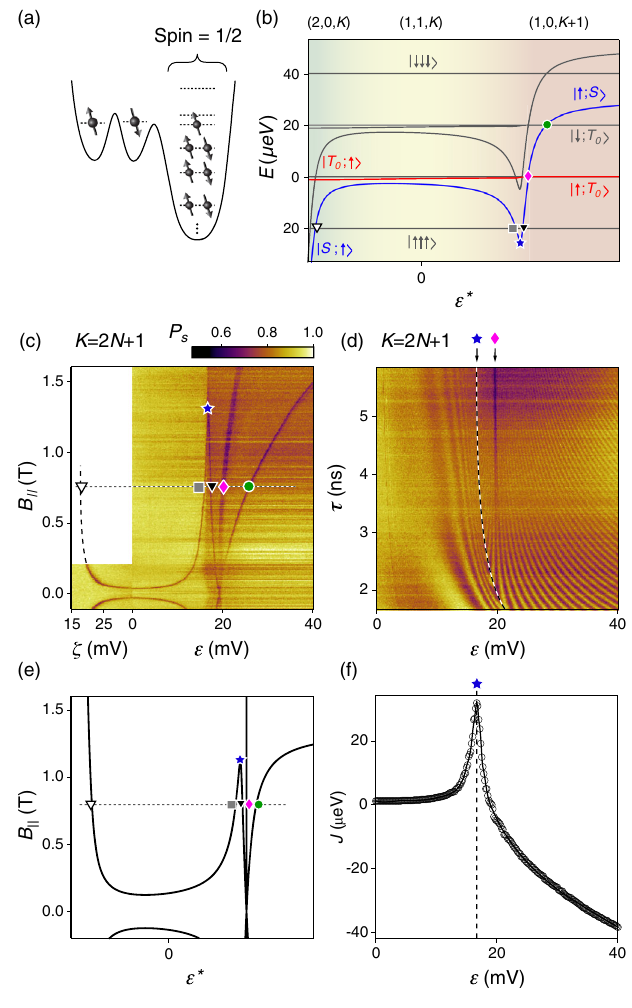
FIG. 9. (a) Schematic of the odd-occupied multielectron quan- tum dot with spin- 1 = 2 ground state, tunnel coupled to the two- electron double quantum dot. (b) Calculated energy diagram at the transition between ð 2 ; 0 ; 2 N þ 1 Þ , ð 1 ; 1 ; 2 N þ 1 Þ , and ð 1 ; 0 ; 2 N þ 2 Þ charge configurations, for a finite magnetic field B k ¼ 900 mT and input parameters motivated by the observed spectrum in (c). Markers indicate crossings revealed by the leakage spectroscopy measurement presented in (c). Energies are measured relative to the energy of the state j Q i ∝ j ↑↑ ↓ iþ j ↑ ↓ ↑ i þ j ↓ ↑↑ i . (d) Time-resolved measurement of exchange oscillations between the 2 N þ 1 occupied spin- 1 = 2 multielectron quantum dot and the middle electron, obtained at zero magnetic field. Color scale as in (c). The dashed line indicates pulse parameters for which the resulting quantum state is to first order insensitive to fluctuations in ε . (e) Leakage spectrum expected from the Hubbard model. (f) Exchange profile J ð ε Þ extracted from the pattern of exchange oscillations in